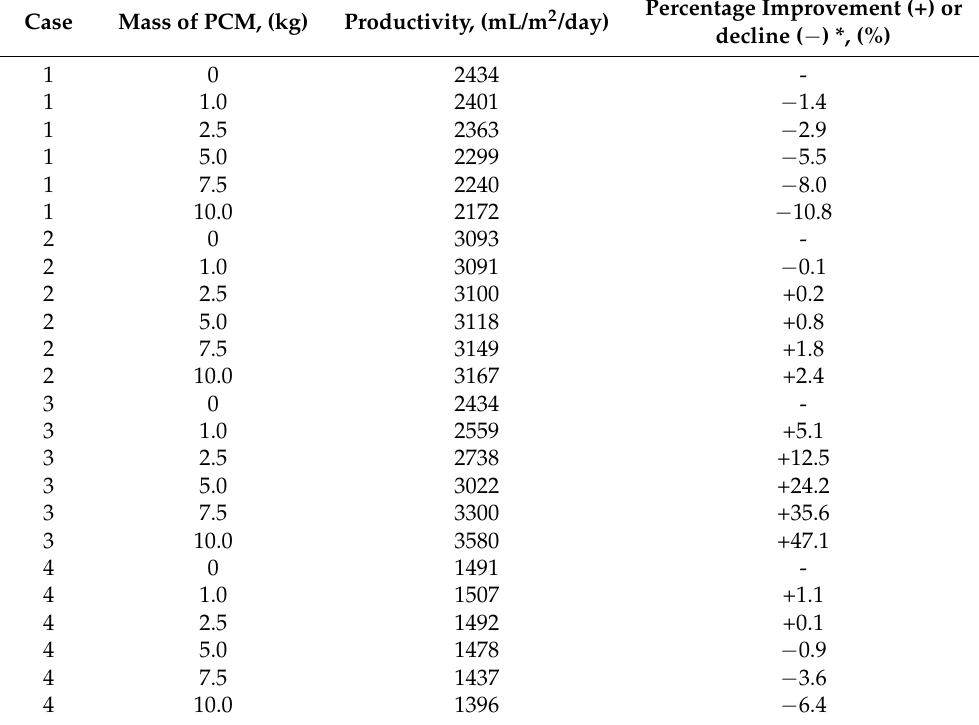
Figure 17. Water temperature in the SS with different masses of PCM — Case 3.